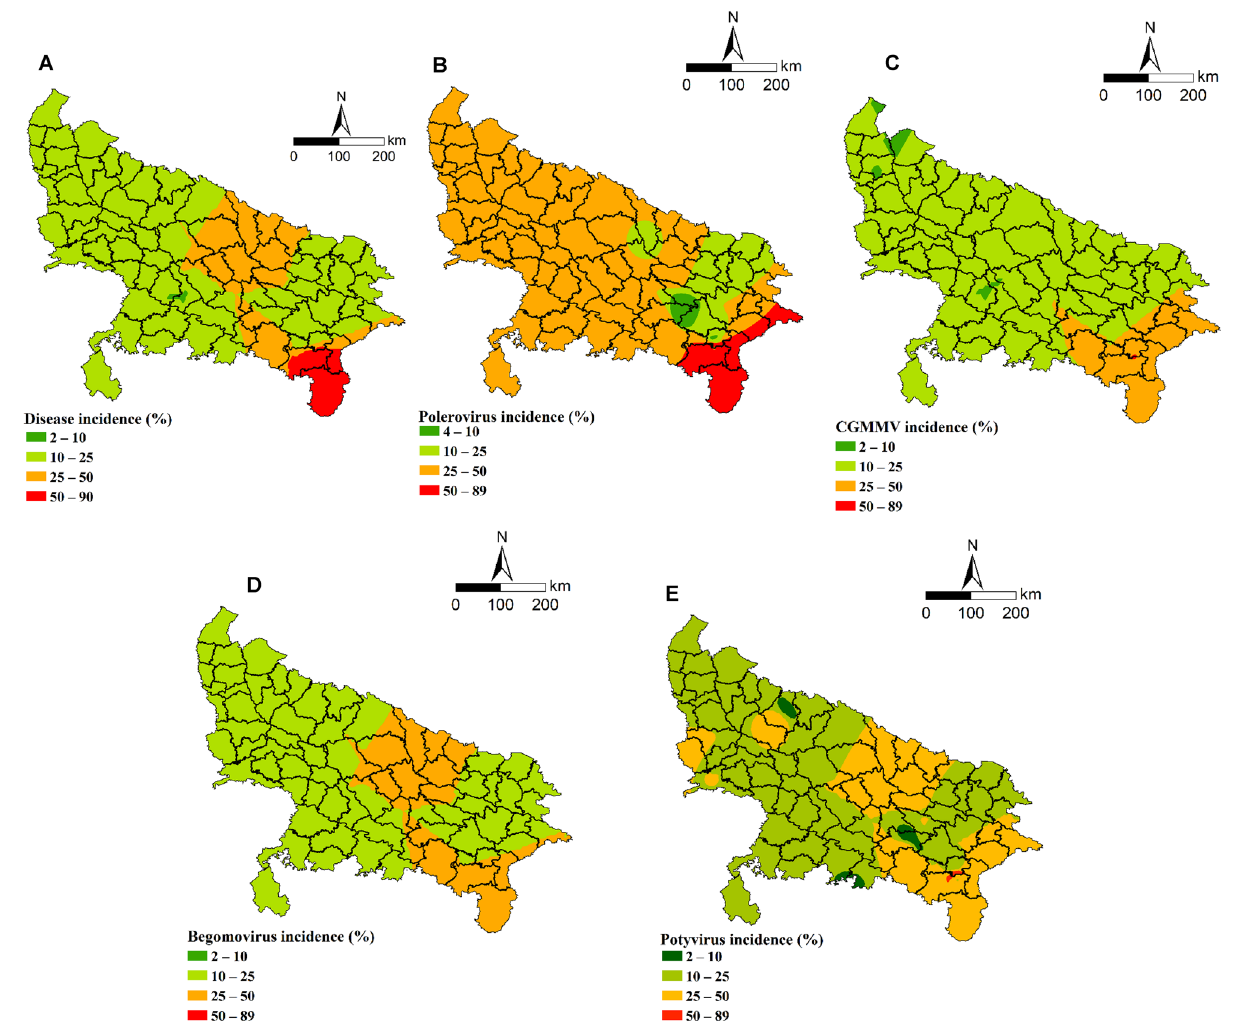
Figure 6. Map showing predicted distribution and incidence proportion of cucurbit viruses in the Uttar Pradesh state using ArcGIS 9.1 software.